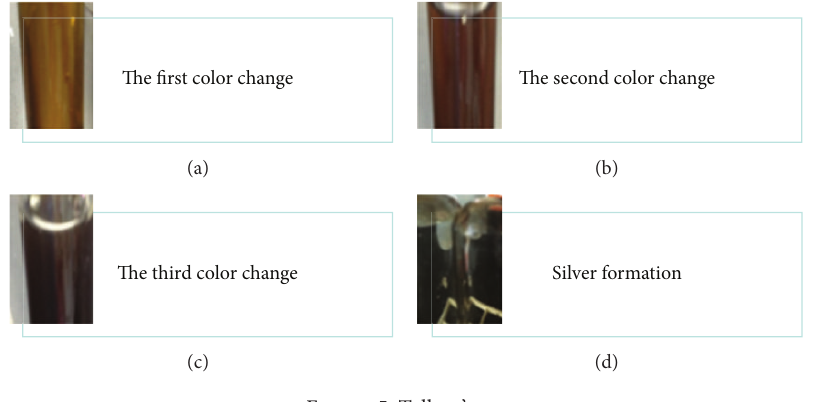
Figure 5: Tollens’